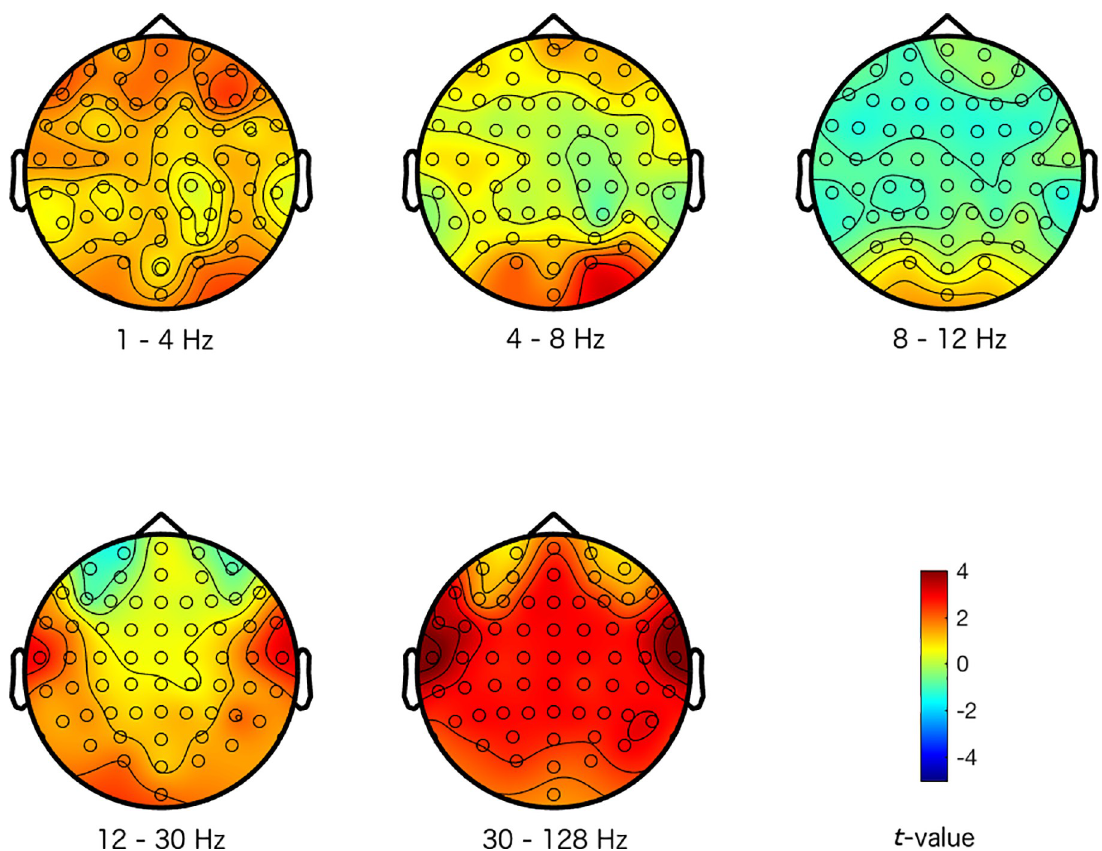
Fig 4. Maps of the difference between a disgust response and the other emotional responses. The colors represent t -values. The different scalp maps show the contrast (expressed in t -values) between activity representing a disgust response, and activity representing the other emotional responses for the specific frequencies that are indicated below the maps (the delta (1–4 Hz), theta (4–8 Hz), alpha (8– 12 Hz), beta (12–30 Hz), and gamma (30–128 Hz) frequency range respectively), and across the head for the 64 electrodes.